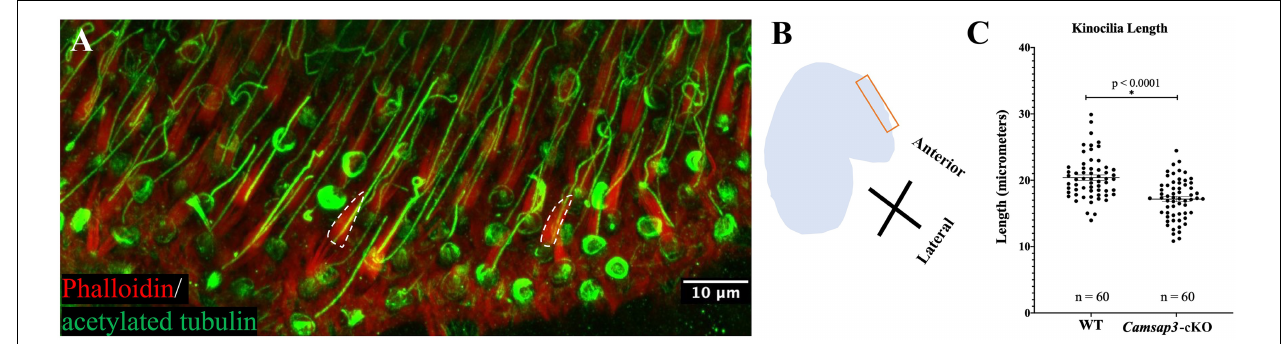
FIGURE 2 | Kinocilia on utricles hair cells from Camsap3 -cKO are shorter than their WT littermates. (A) A representative 3D-reconstruction from z-stacks images of bundles of stereocilia (red) and kinocilia (green) located on the apical surface of hair cells from an utricle of a WT mouse (P386). Antibodies: anti-acetylated tubulin (Green), phalloidin (Red). The dashed line outlines the edge of actin-based stereocilia bundles. Scale Bar = 10 µ m. (B) A schematic diagram showing the region over which Z-stack images of utricle hair cells were collected. (C) Quantification of kinocilia length collected from male WT ( n = 3) and male Camsap3 -cKO littermates ( n = 3) with ages ranging from 10- to 13-month. Each dot represented one kinocilium. Bars represent mean ± SD. Kinocilia on utricles hair cells from Camsap3 -cKO were statistically significant shorter than WT ( p < 0.0001). *Statistically significant difference.